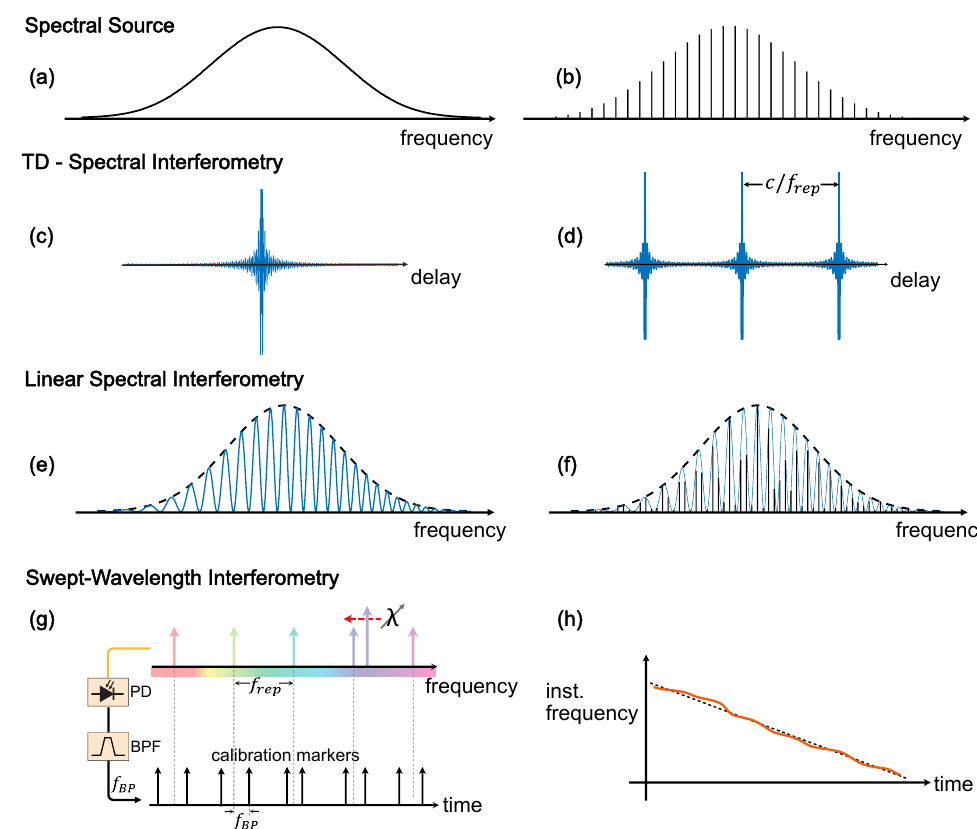
Figure 2. Comparison between spectral sources and the interferometric signals obtained with different configurations. ( a , b ) Spectral sources. ( c , d ) Time domain-spectral interferometry (TD- SI). ( e , f ) Linear spectral interferometry. ( g , h ) Frequency comb assisted laser calibration for SWI. Broadband sources are exemplified with a continuous ( a ) and discrete nature ( b ). The interferogram using a TD approach based on white light is single burst when the difference of the optical path is zero ( c ). In contrast, if a frequency comb is employed, the interferogram pattern consists of several bursts spaced by c / f rep ( d ). The interference signal using an SDI approach is measured with a CCD camera when using a conventional source ( e ) and discrete distribution of spectral components is recorded when using a frequency comb ( f ). In ( g ), a sweeping laser is heterodyned against the frequency comb of repetition rate f rep . Calibration markers are detected every time the scanning laser is ± f BP (central frequency of the bandpass filter) away from the comb line. Beats notes are unevenly spaced for the laser being swept nonlinearly. ( h ) Calibrated instantaneous laser frequency (orange trace) on the top of linear approximation (dotted